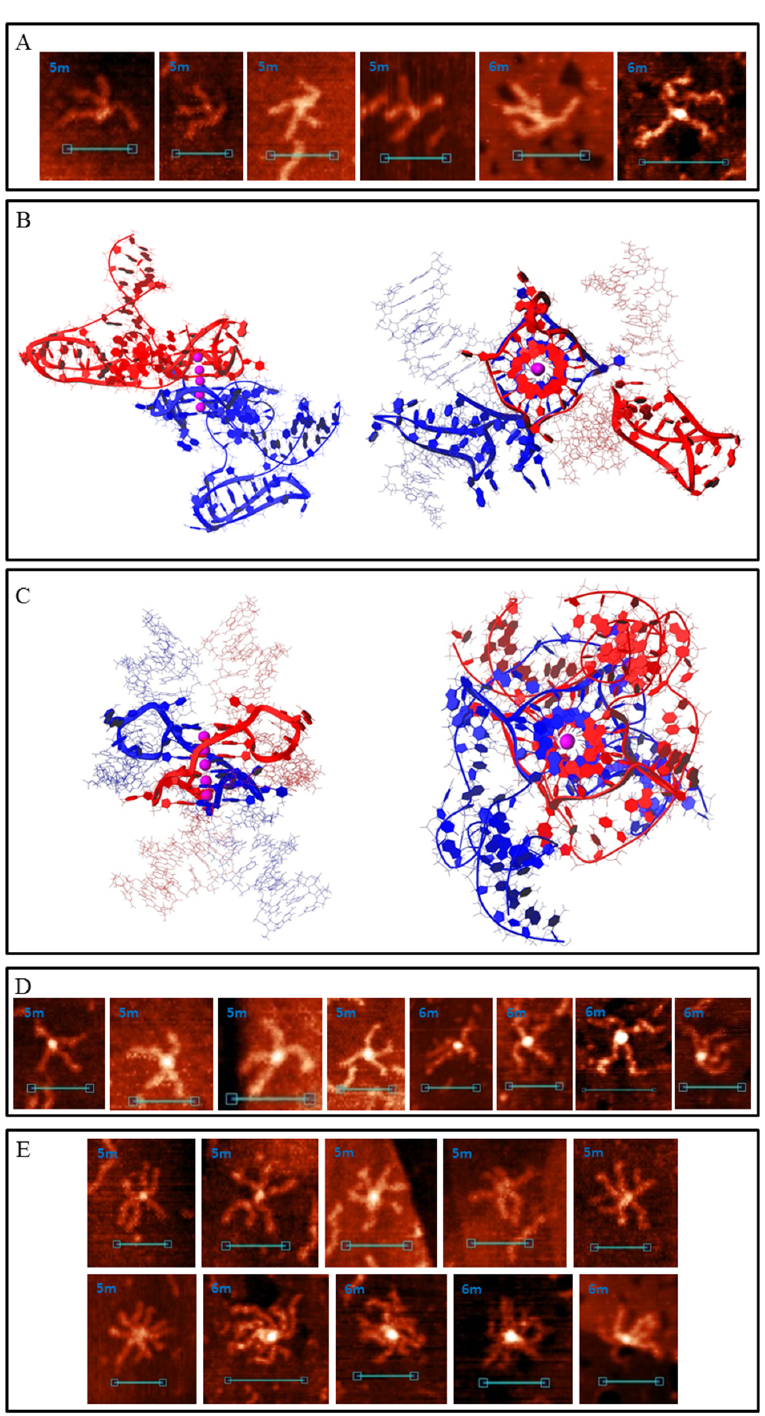
Figure 7. G4/IM-synaptic complexes formed by 5m and 6m samples. ( A ) Examples of bimolecular complexes, formed through stacking of intramolecular G4s which contain 5-base loops, revealed by AFM. Scale bars: 50 nm. ( B ) Molecular model of the structure, consistent with ( A ) (with two IMs folded). ( C ) Molecular model of duplex joining through the interlocked G4-dimer in which each G4 contains 5-base loops. ( D ) Examples of the complexes, consistent with model ( C ), revealed by AFM. Scale bars: 50 nm. ( E ) Examples of small multimeric G4/IM-synaptic complexes, formed by 5m and 6m samples.